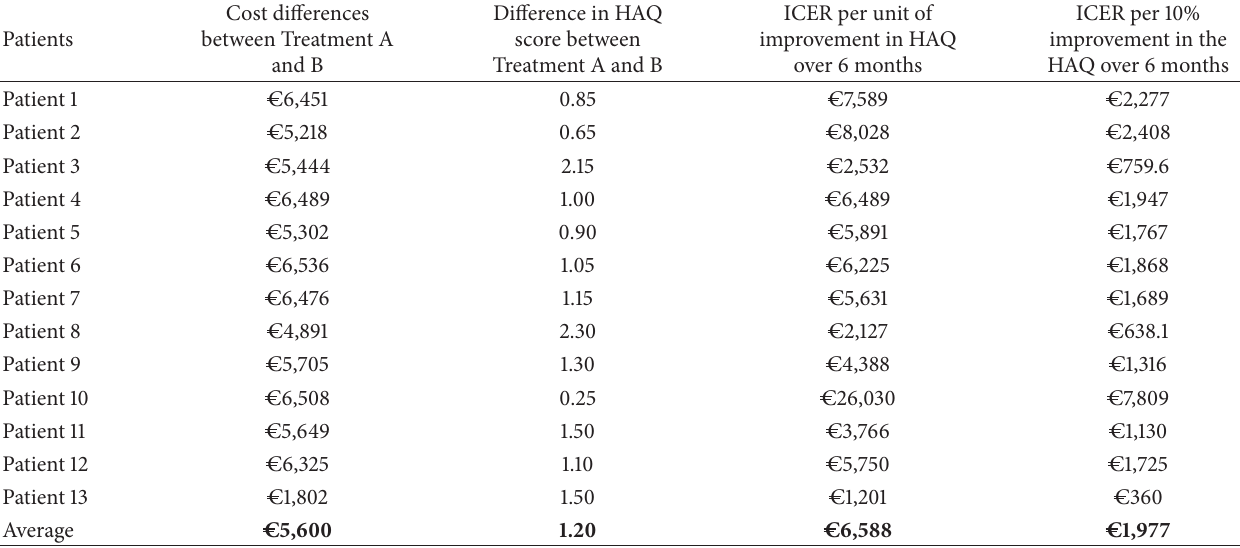
Table 3: Resulting ICERs in terms of improvement in the HAQ.